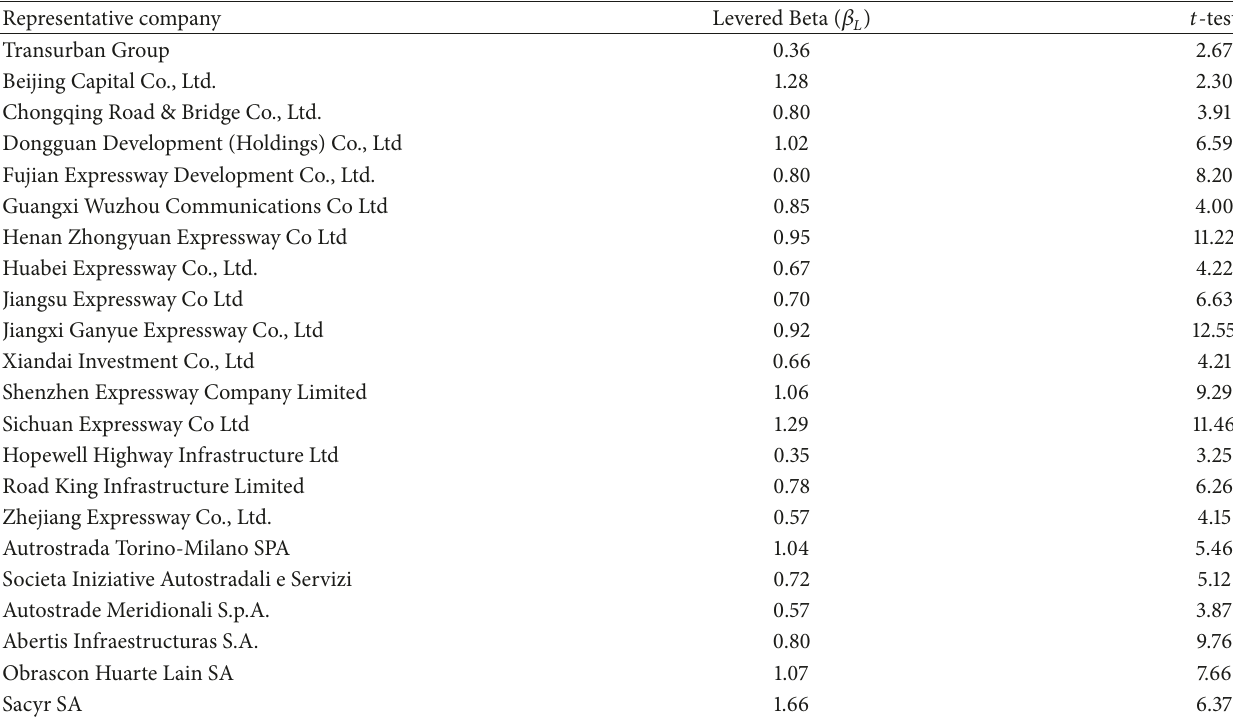
Table 2: Levered Betas of equity for representative companies ( 𝛽 𝐿 ).